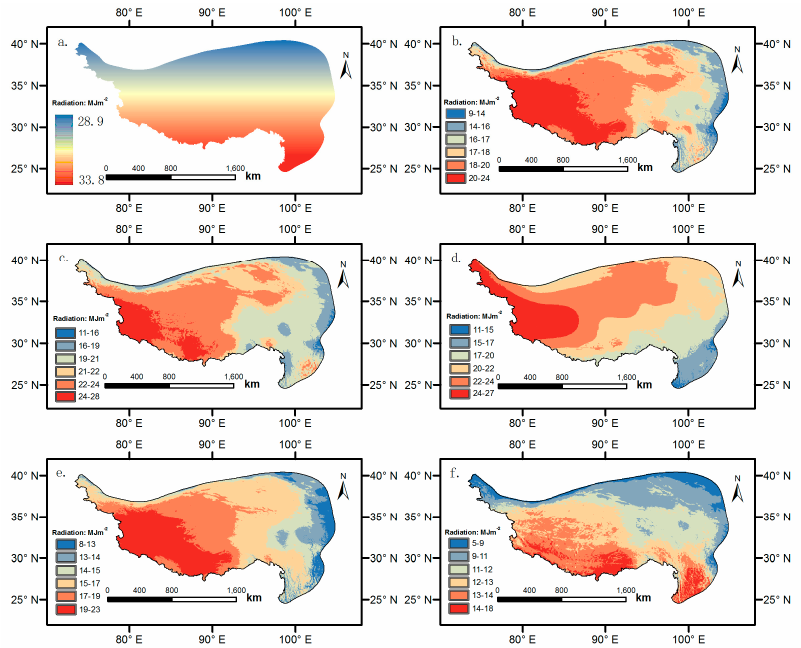
Figure 8. Spatial distribution of the annual mean of daily solar irradiation over the Tibetan Plateau. ( a ) Extra-terrestrial radiation, ( b ) Annual mean of daily solar irradiation, and the seasonal mean of daily solar irradiation in ( c ) spring, ( d ) summer, ( e ) autumn, and ( f ) winter (unit: MJ·m − 2 ).